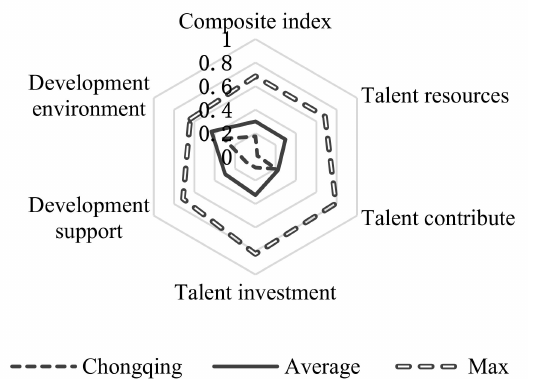
Figure 1. Radar chart of talent competitiveness index of the intelligent industry in